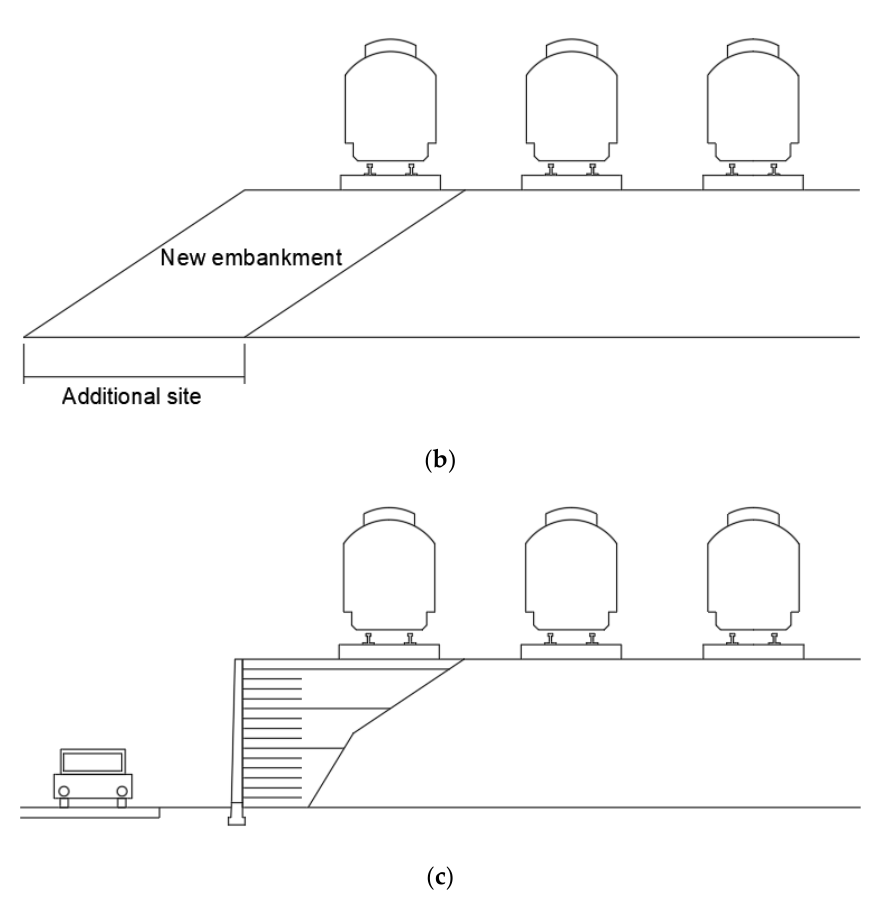
Figure 3. Differences in widening embankment based on the method employed: ( a ) Railway embankment; ( b ) Widening with standard embankment; ( c ) Widening with RSR